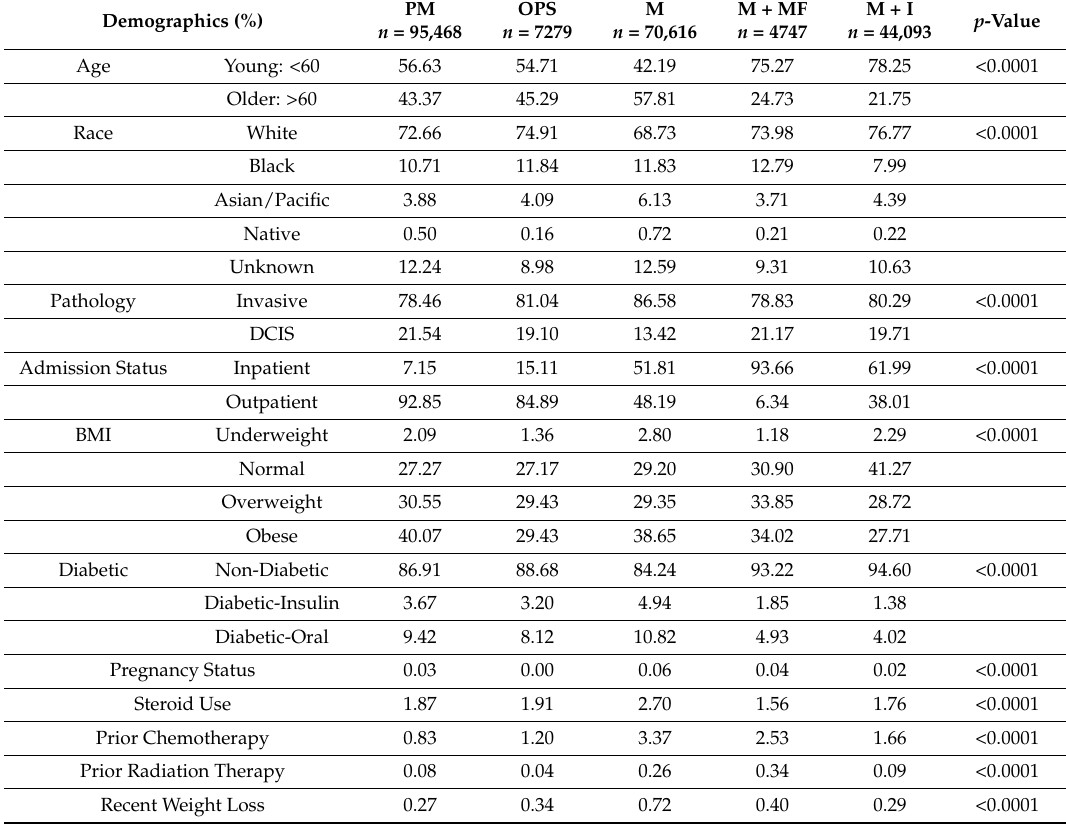
Table 2. Patient Demographics and Comorbidities in each Surgical